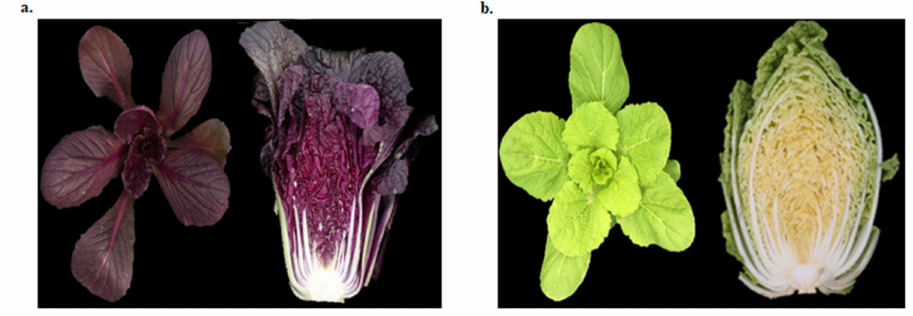
Figure 10. Chinese cabbage at young and mature stages. ( a ). Green (GCC) and ( b ). reddish purple (RPCC).